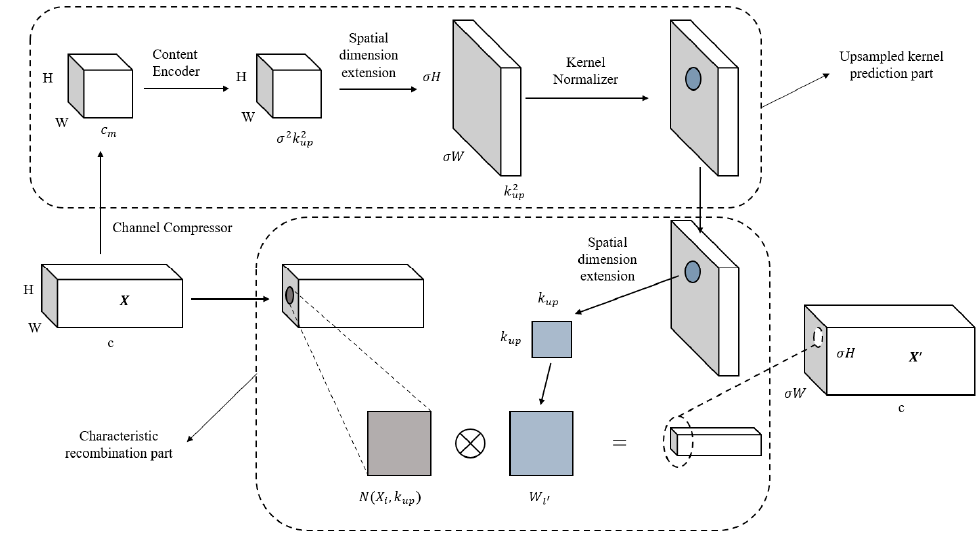
Figure 5. Structure diagram of the CARAFE up-sampling operator.